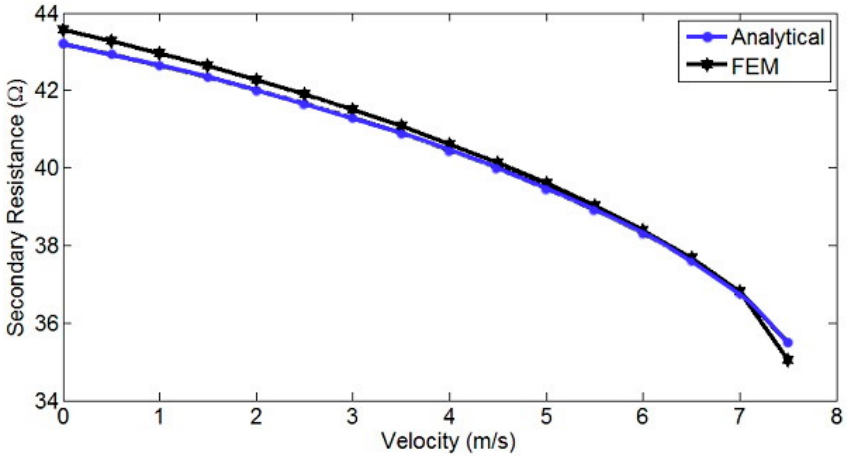
Figure 6. Magnetic inductance variations versus the velocity.